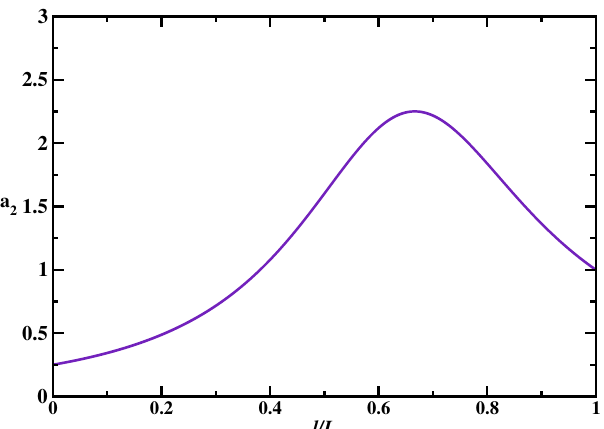
Figure 5. Ratio of the mean search times as a function of the normalized distance between the targets for single-target and two-target systems ( l is the distance between between targets, L is the DNA length). The single target is in the middle of the chain. In the two-target system, one of the specific sites is fixed at the end and the position of the second one is varied. The parameters used in calculations are: u = k on = 10 6 s − 1 ; k of f = 10 − 4 s − 1 ; and L = 10,000. Adapted with permission from Ref.